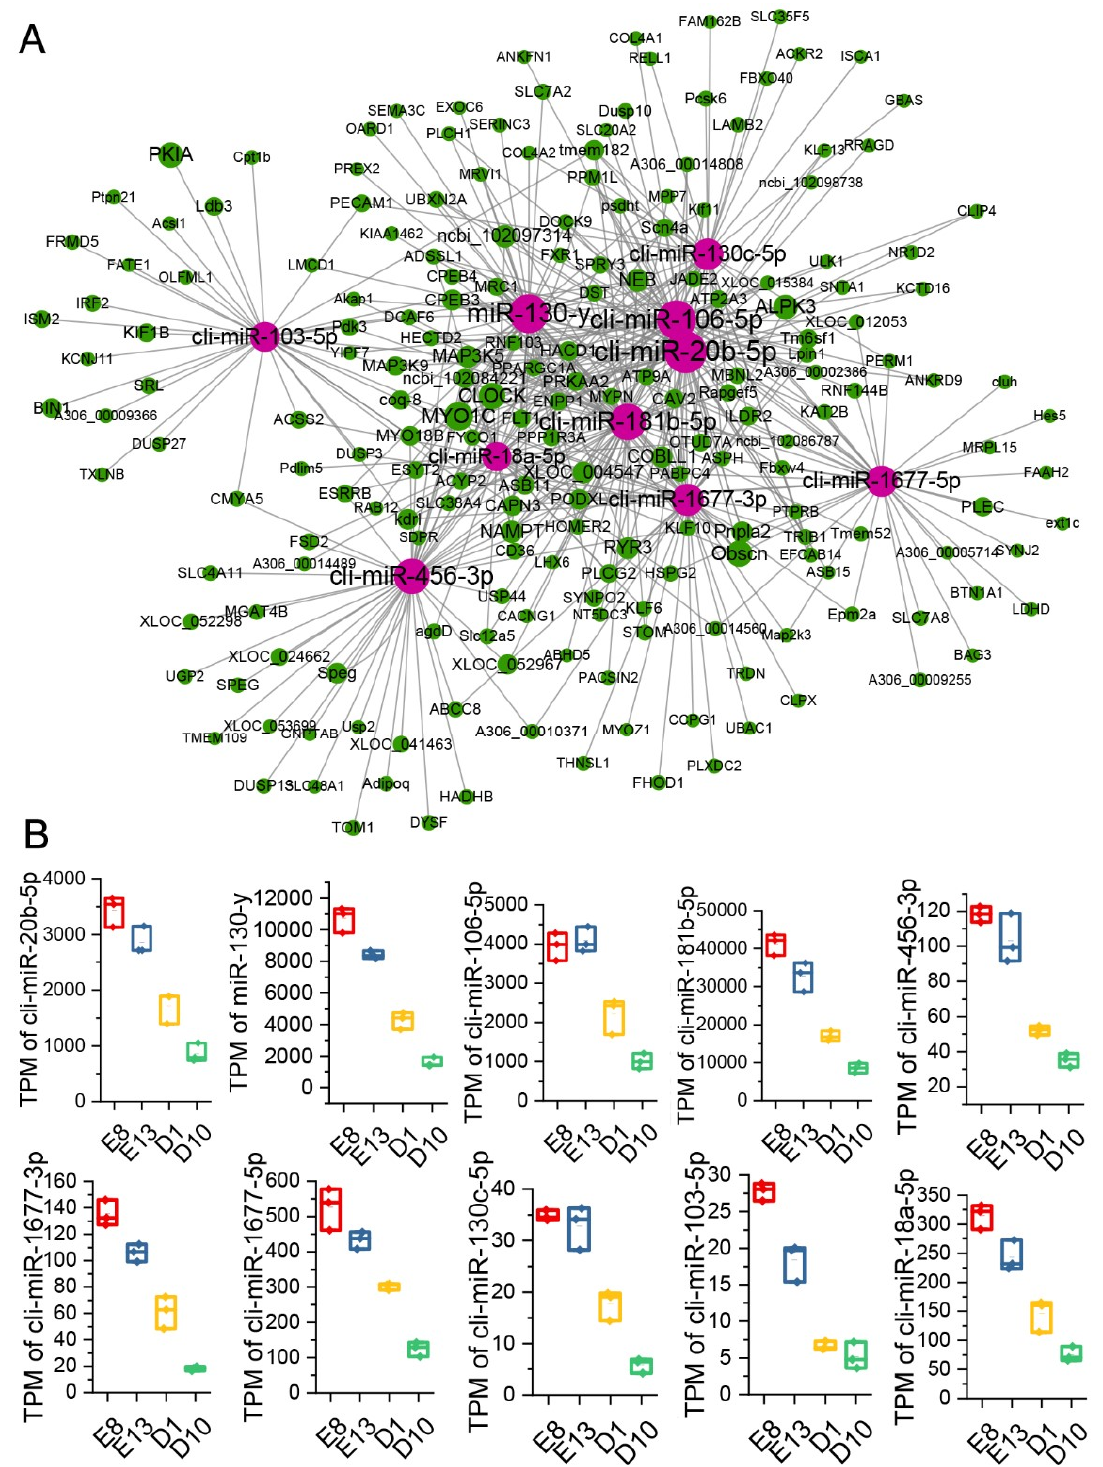
Figure 3. Identification and visualization of hub miRNAs in Network A. ( A ) Visualization of inter- actions between hub miRNAs and their target genes in Network A. The red node represents miRNA, the green node represents mRNA, and the size of the node represents the connectivity degree, respectively. ( B ) The expression patterns of the ten hub miRNAs during the growth and development of pigeon skeletal muscle. All the ten hub miRNAs are highly expressed during the embryonic development stage, and their expression is significantly downregulated during the growth stage.